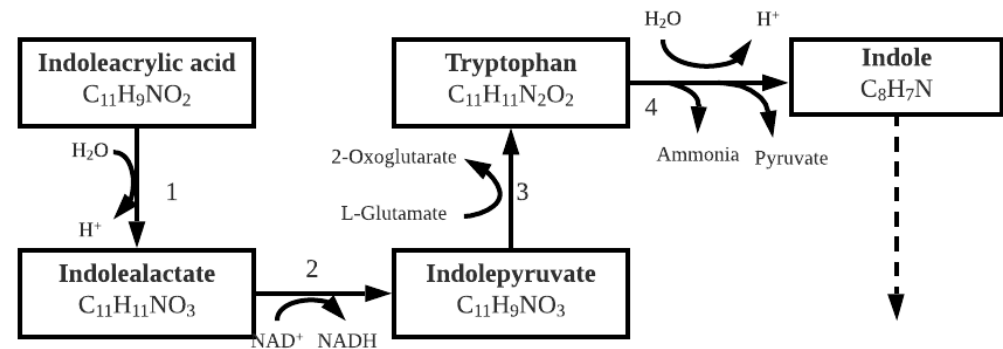
Figure 7. Catabolic pathway for indoleacrylic acid degradation, enzyme activities are 1: indolelactate dehydratase; 2: indolelactate dehydrogenase; 3: aromatic amino acid aminotransferase; 4: tryptophanase [34].